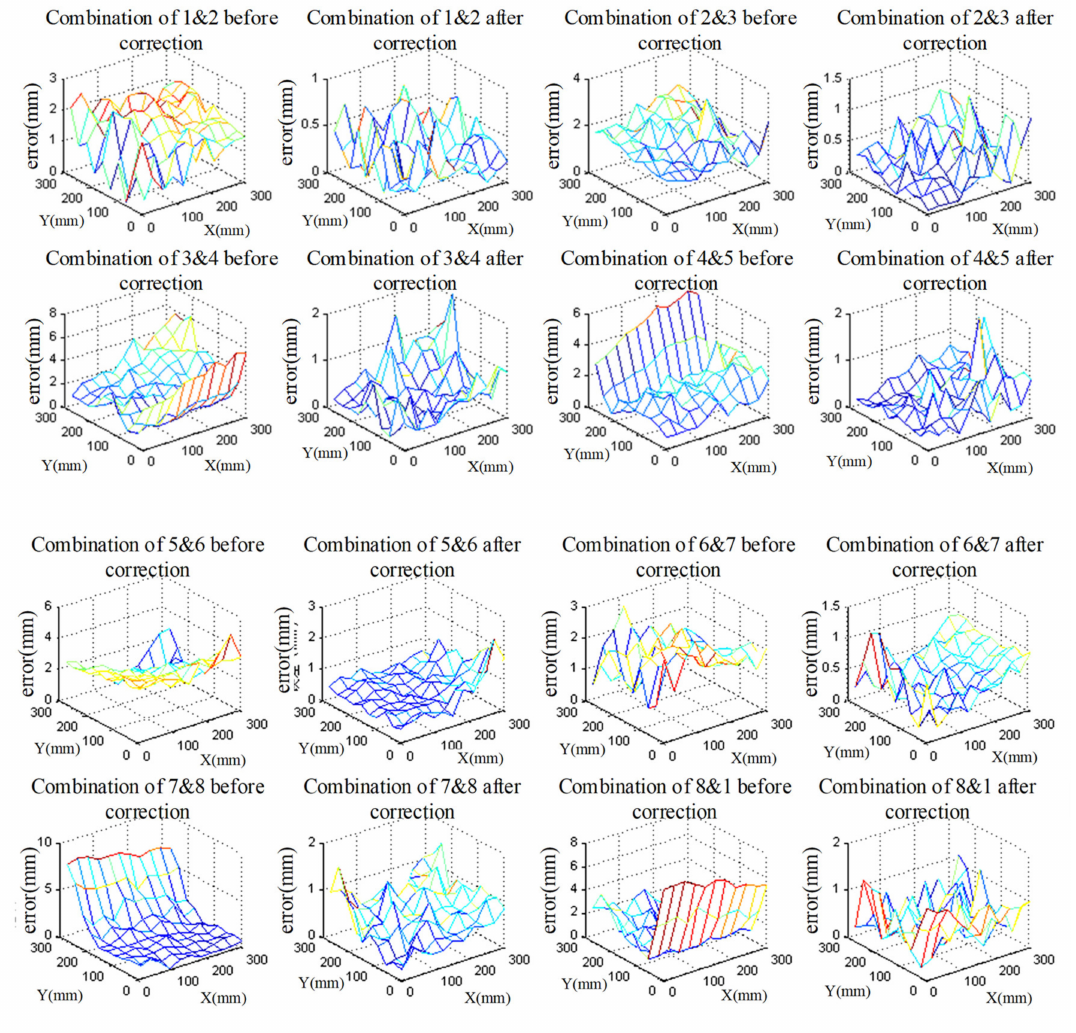
Figure 15. Error of each camera combination before and after correction.